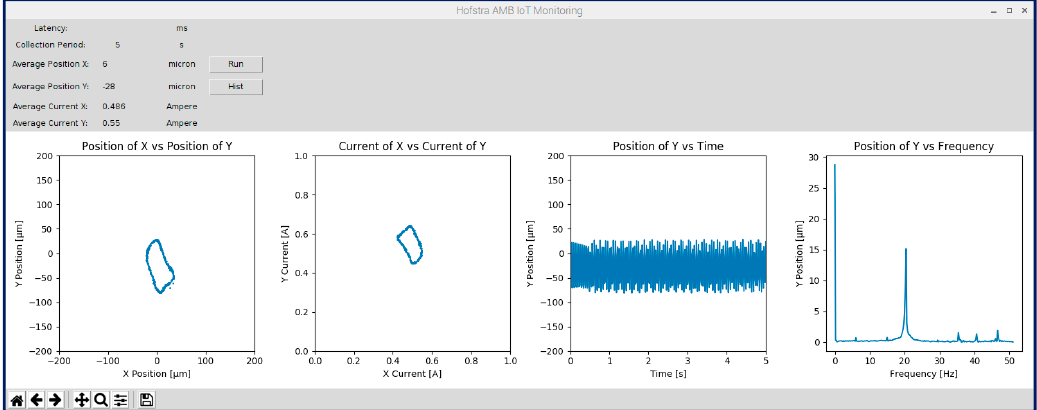
Figure 9. AMB IoT condition monitoring GUI display for rotating shaft with two balanced collars.